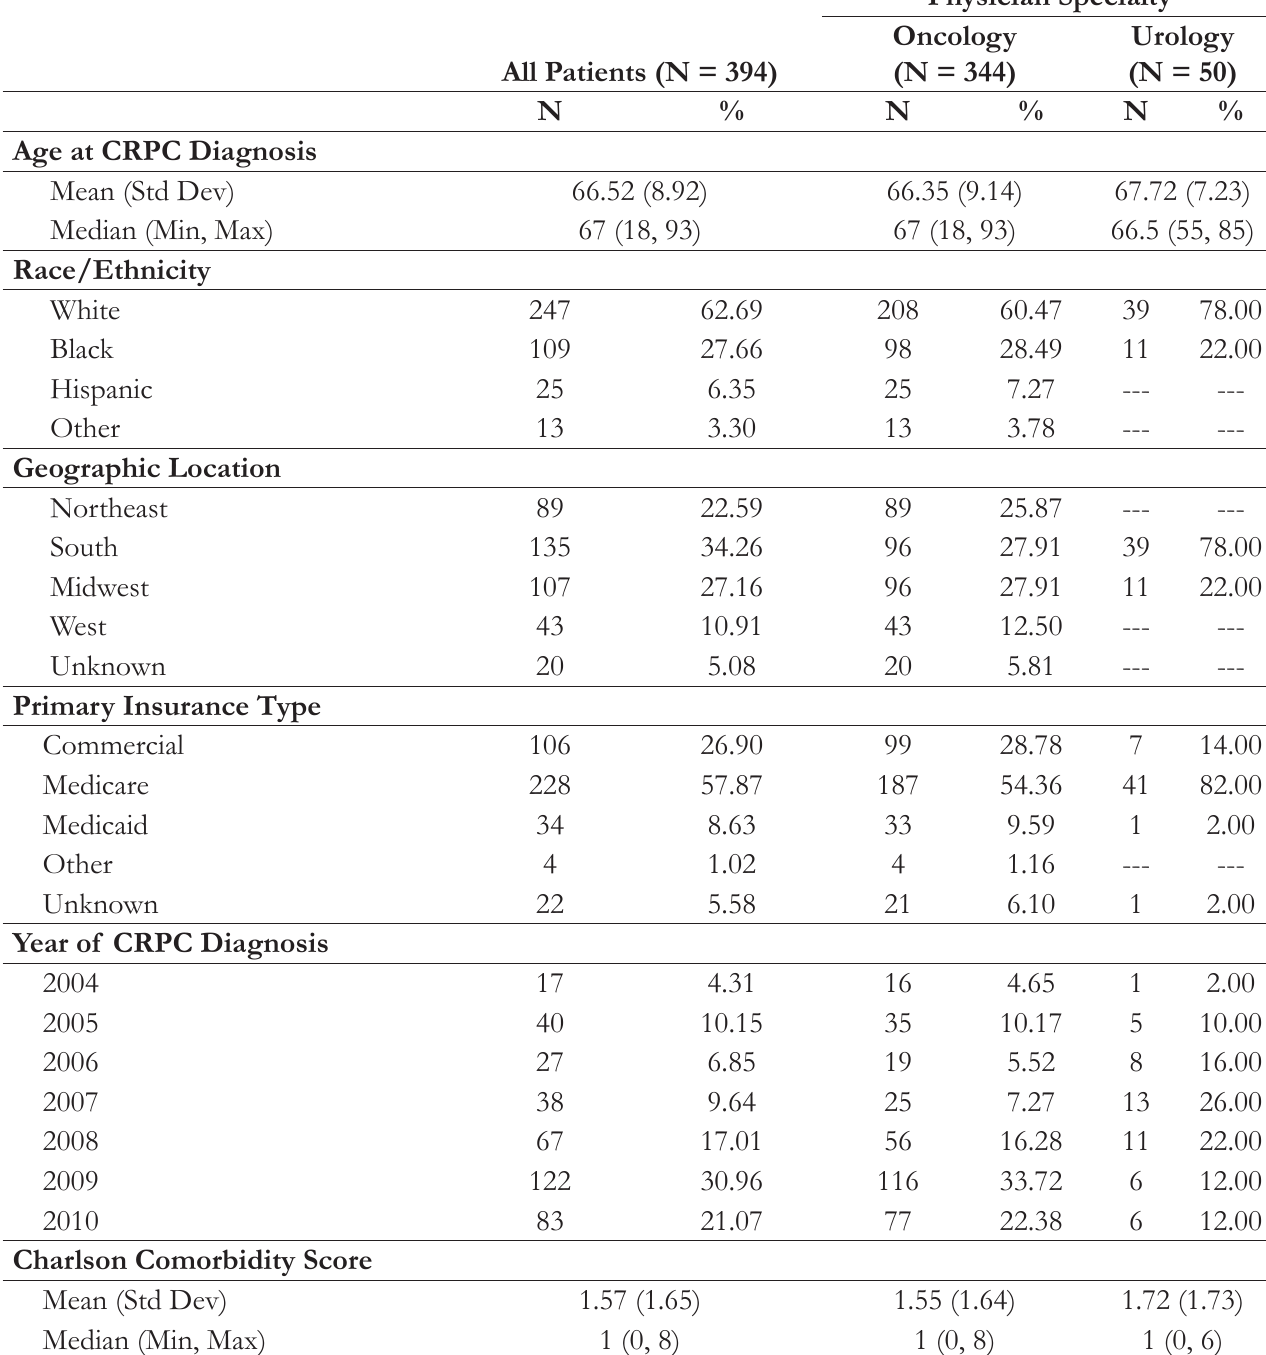
Table 1. Patient Characteristics, by Specialty of Treating